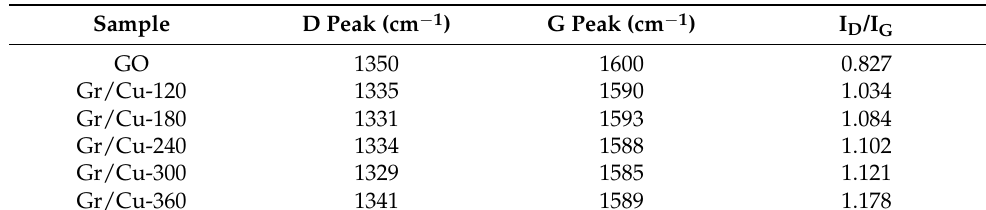
Figure 7. Raman spectra of the GO and Cu-Gr. Table 4. The position and the ratio of D peak and G peak.